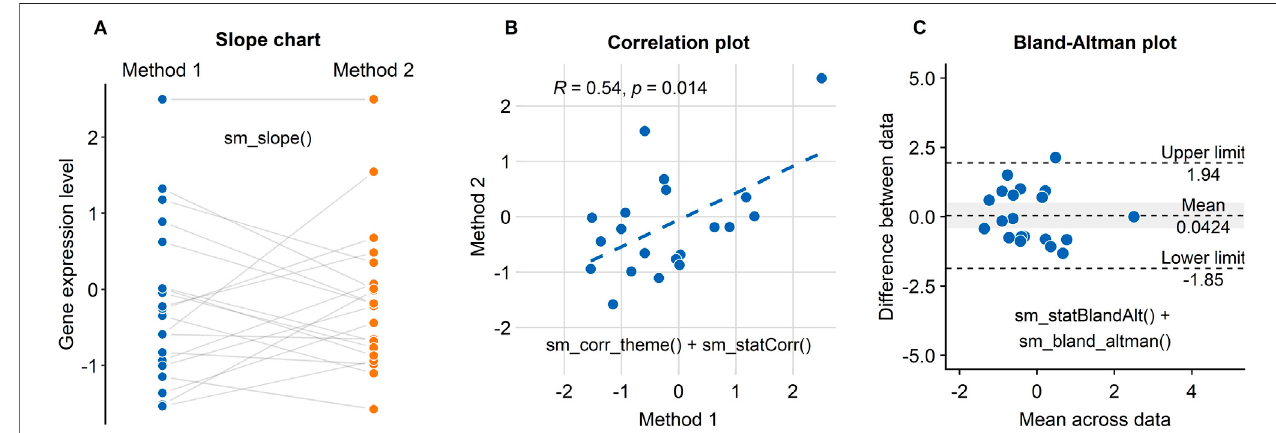
FIGURE 7 | Three fi gures that examine the test-retest reliability of a new method/technology to measure gene expression have been created using smplot . (A) A slope chart drawn using “ sm_slope() ” .The blue points representdata from thestandard method, whereas theorange points show data from the newmethod.Each dot representsanindividualsample.Thegreylinesindicatethepairingofthepoints.Ifthegreylinesuniformlyhaveapositiveornegativeslope,thenonecaninferthatthenew method consistently show data of higher or lower values, respectively. (B) A correlation plot drawn using “ sm_corr_theme() ” and “ sm_statCorr() ” . Unfortunately, thereisanextremepointatthetop-rightofthepanel;itheavilyskewsthecorrelationtoberobust.Withoutit,thecorrelationismuchweaker,i.e., R (cid:1) 0.24, p (cid:1) 0.32. (C) A Bland-Altman plot drawn using “ sm_statBlandAlt() ” and “ sm_bland_altman() ” . The difference in data between the two methods are plotted as a function of the mean acrossthedata from thetwo methods. Theupper and lower dashed lines denote 95%limits ofagreement; thewider the range encapsulated bythe limits ofagreement, the more measurement variability there is between the methods. The dashed line in the middle indicates the mean of the difference between the data from the two methods. The grey area represents 95% con fi dence interval of the difference in data between the methods estimated from a t-distribution. If the middle-dashed line (mean difference) doesnot overlap withthe greyarea (95%con fi denceinterval),then themean difference issigni fi cantly differentfrom 0based on one-sample t-test ( p < 0.05), thereby indicating that the new method shows a very poor agreement with the standard method. In this panel, however, we see an